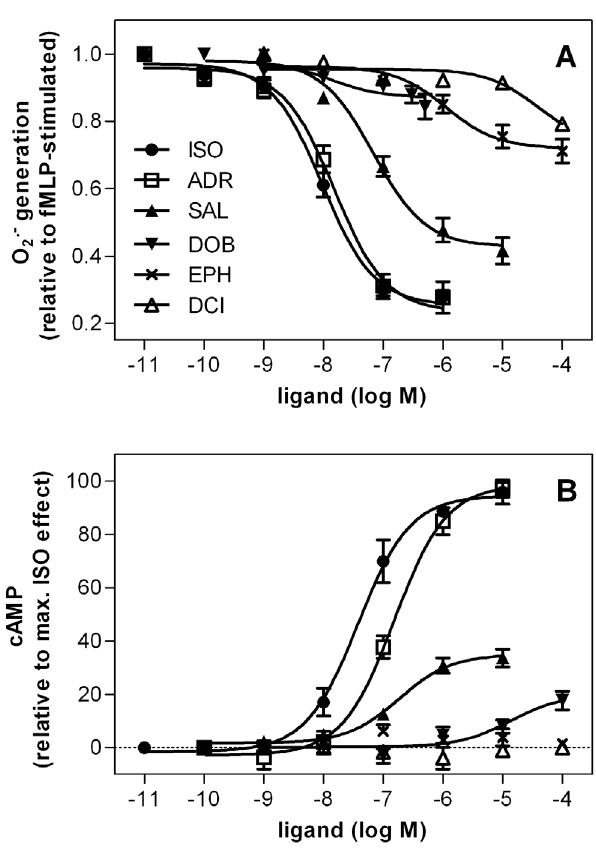
Figure 3. Concentration-response curves for b 2 AR agonists determined in the O 2 N 2 assay (A) and cAMP assay (B). The O 2 N 2 assay (1 6 10 5 cells per well) and the cAMP assay (5 6 10 5 cells per cup) were performed as described in Materials and Methods . Data were analyzed by non-linear regression and were best fitted to sigmoidal concentration/response curves. Data shown are the means 6 S.E.M. of four to nine independent experiments performed in triplicate. As DOB at concentrations higher than 500 nM caused reduction of ferricyto- chrome c per se , the maximal DOB concentration examined in the O 2 N 2 assay was 500